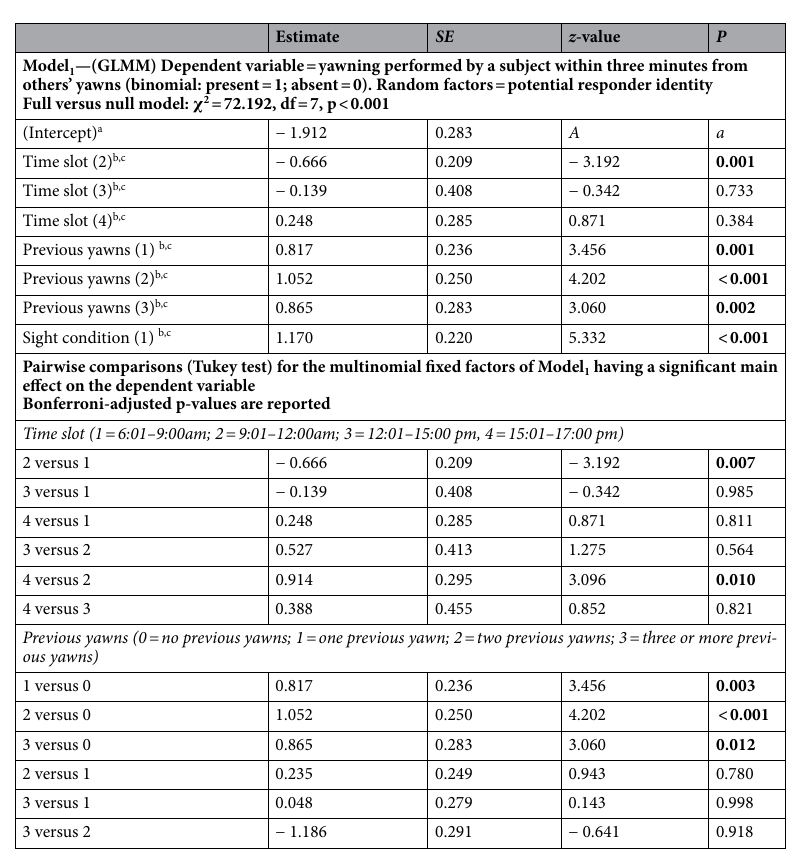
Table 1. Results of Model 1 , testing what contextual factors can modulate yawning performed by a subject within three minutes from others’ yawns and the pairwise comparisons for the multinomial, fixed factors having a significant main effect on the dependent variable. a Not shown as not having a meaningful interpretation. b Estimate ± SE refer to the difference of the response between the reported level of this categorical predictor and the reference category of the same predictor. c These predictors were dummy coded. Time slot was coded as: 1 = 6:01–9:00am; 2 = 9:01–12:00am; 3 = 12:01–15:00 pm, 4: 15:01–17:00 pm. Previous yawns were coded as: 0 = no previous additional yawns; 1 = one previous yawn; 2 = two previous yawns; 3 = three or more previous yawns. Sight condition was coded as: 0 = yawn(s) outside the visual range; 1 = yawn(s) within the visual